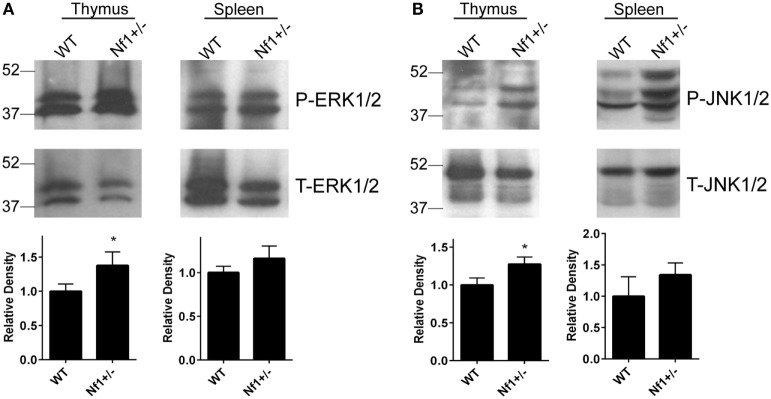
Increased activation of ERK and JNK in the spleen and thymus of Nf1+/− mice. Splenocytes and thymocytes were treated with Phorbol 12-myristate 13-acetate (100 ng/mL) for 30 min. The cells were then lysed and resolved on a 10% SDS-PAGE gel for the detection of phosphorylated and total ERK1/2 (A) and JNK1/2 (B) expression by Western blot analysis. The relative levels of phosphorylated ERK1/2 and JNK1/2 compared with the total respective proteins were quantified by densitometry. Combined results from multiple experiments are shown in the bar graphs. The data are plotted as the mean ± SD. *p < 0.05.